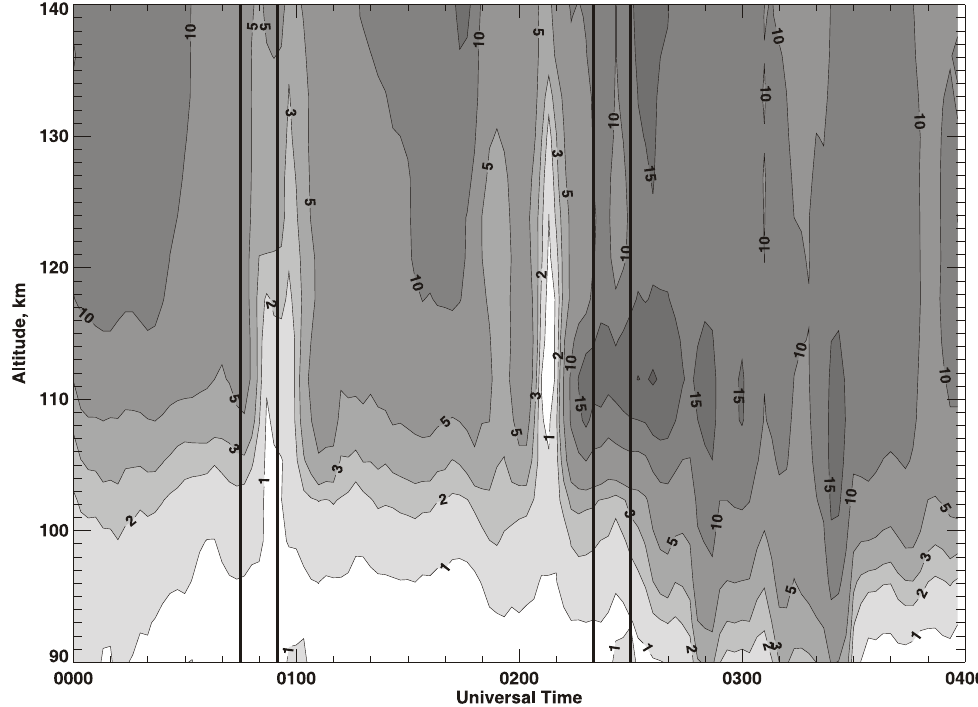
Fig. 3. The EISCAT E-layer electron density contours in units of 10 10 m − 3 . Vertical lines limit two intervals of data which were used in the